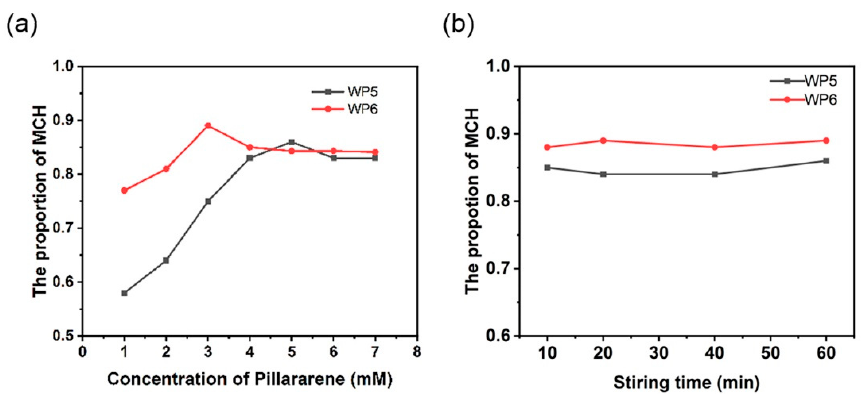
Figure 2. The proportion of MCH in the extraction phase at different ( a ) pillararene concentrations and ( b ) stirring times. and ( b ) stirring